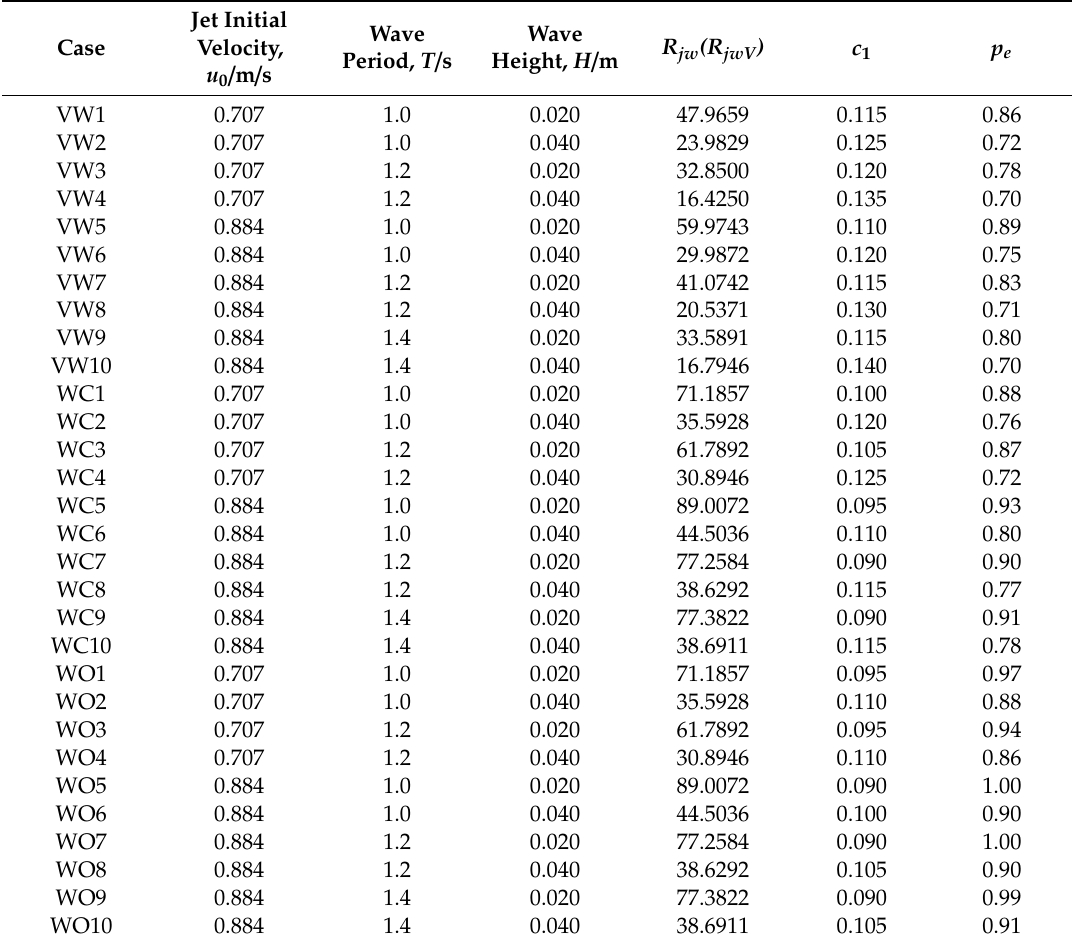
Table 2. Calibrated values of c 1 and p e for the non-buoyant jet in wave